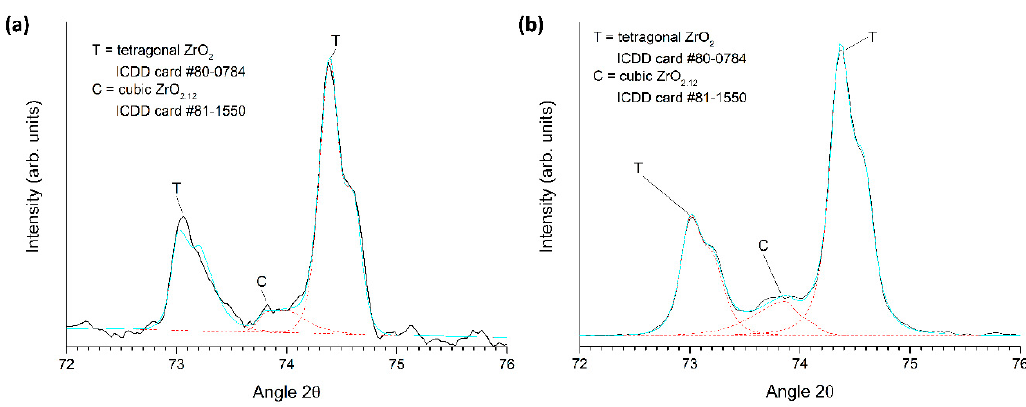
Figure 13. Magnified XRD patterns of ( a ) a conventionally sintered sample and ( b ) a two-step sintered sample (T1 = 1400 °C, T2 = 1350 °C, t2 = 20 h). Both samples prepared from as-received powder.